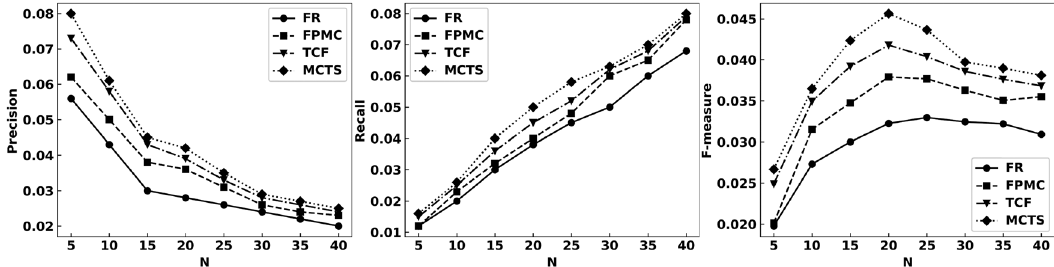
Figure 1: Each algorithm is based on the comparison of the precision, recall, and F - measure of the data of